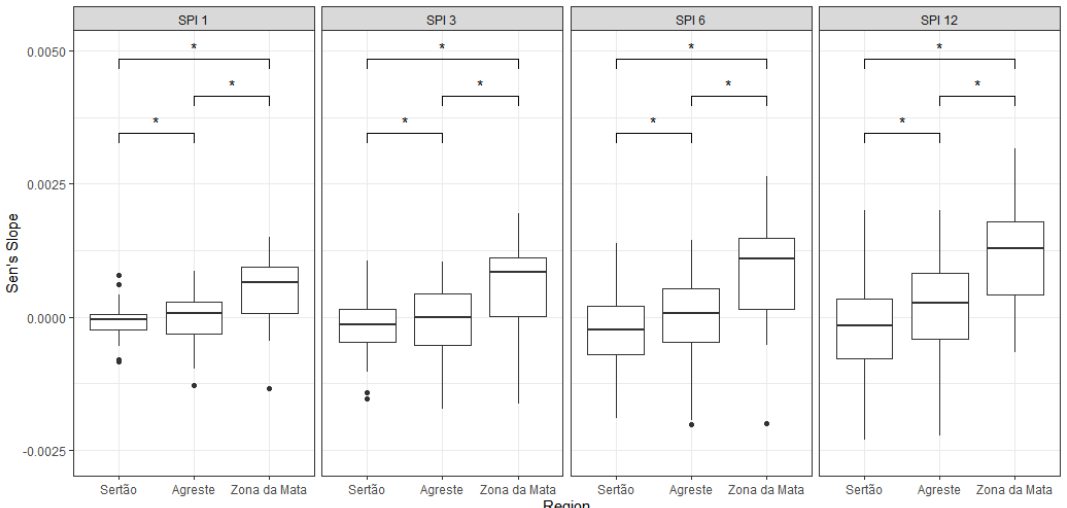
Figure 7. Sen’s slope boxplots for each of the three regions for di ff erent time scales (SPI-1, SPI-3, SPI-6 and SPI-12). The star symbol “*” indicates that there is a significant di ff erence between the regions at the 5% significance level ( pv < 0.05 ).